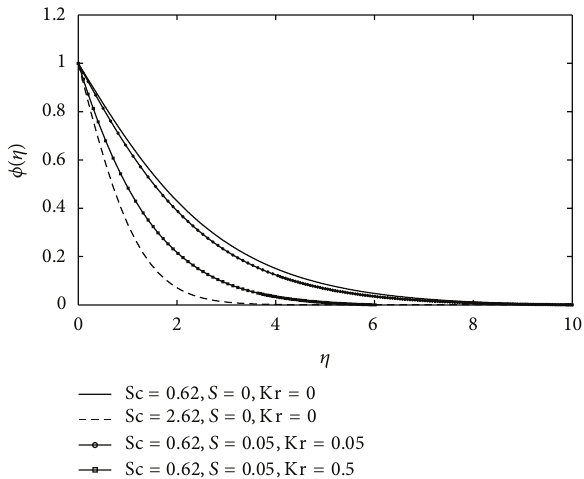
Figure 18: Concentration profiles for different values of Sc, 𝑆 , and Kr for Ha = 0.1 , Gr = 0.1 , Gc = 0.1 , Bi = 0.1 , Nc = 0.01 , and Pr = 0.72 .